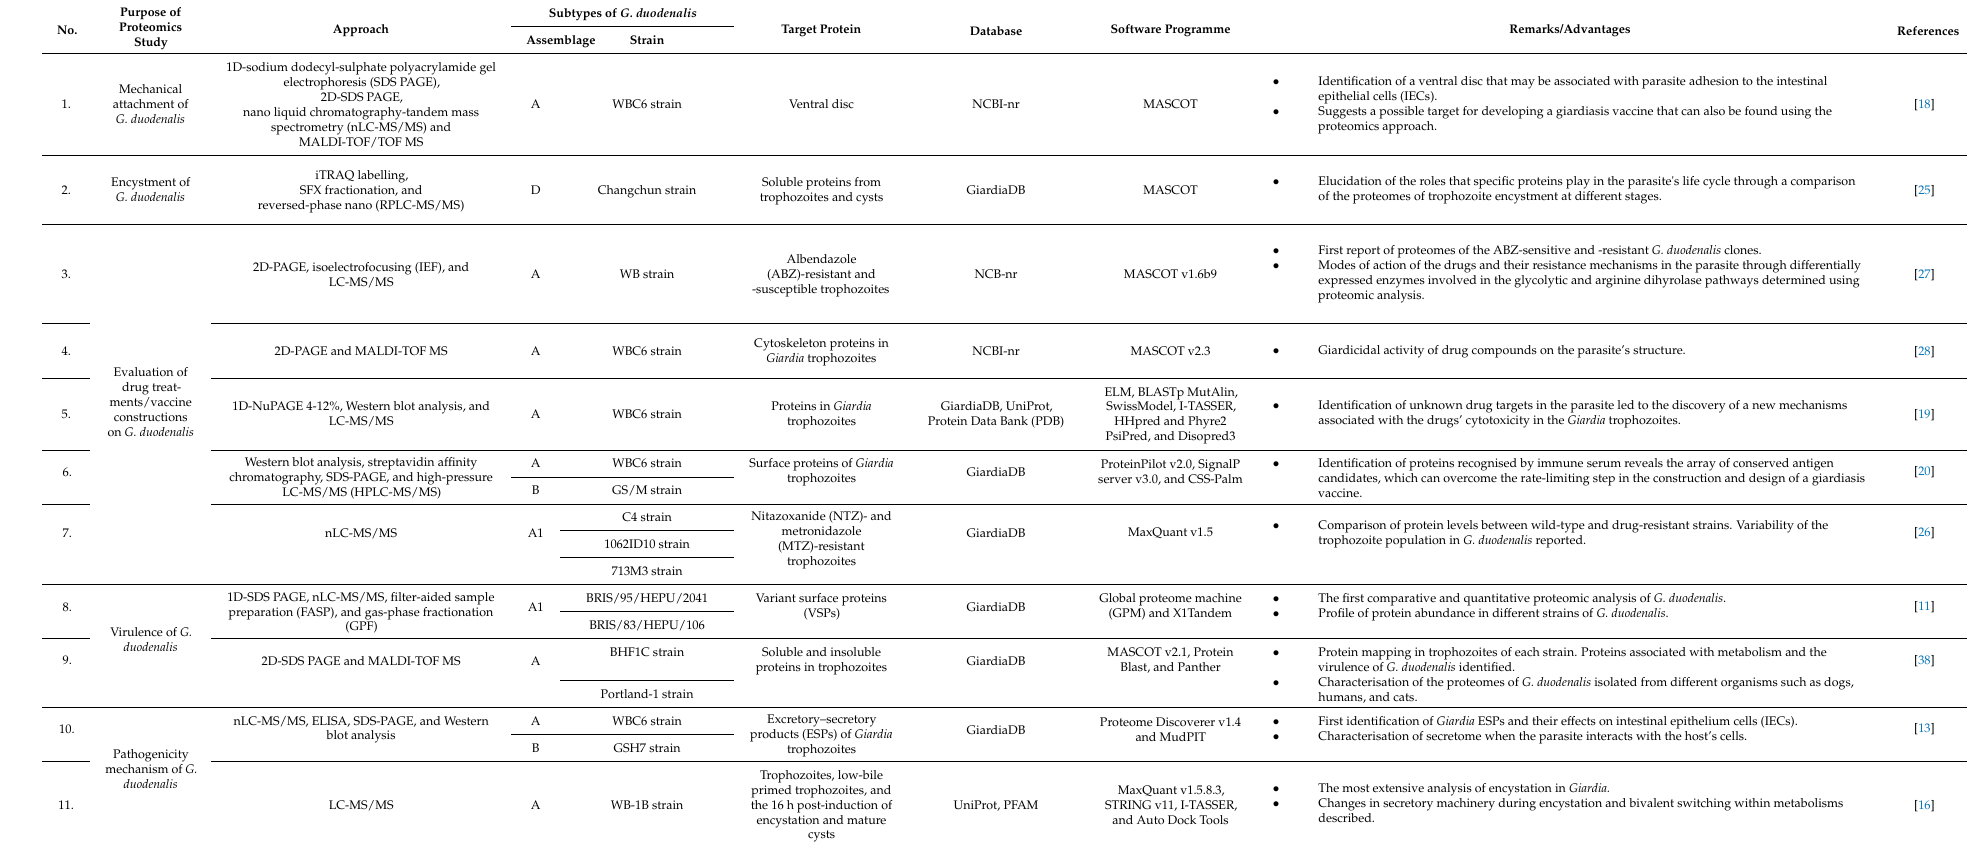
Table 1. Summary of proteomics-based analyses of G. duodenalis from 2012 to